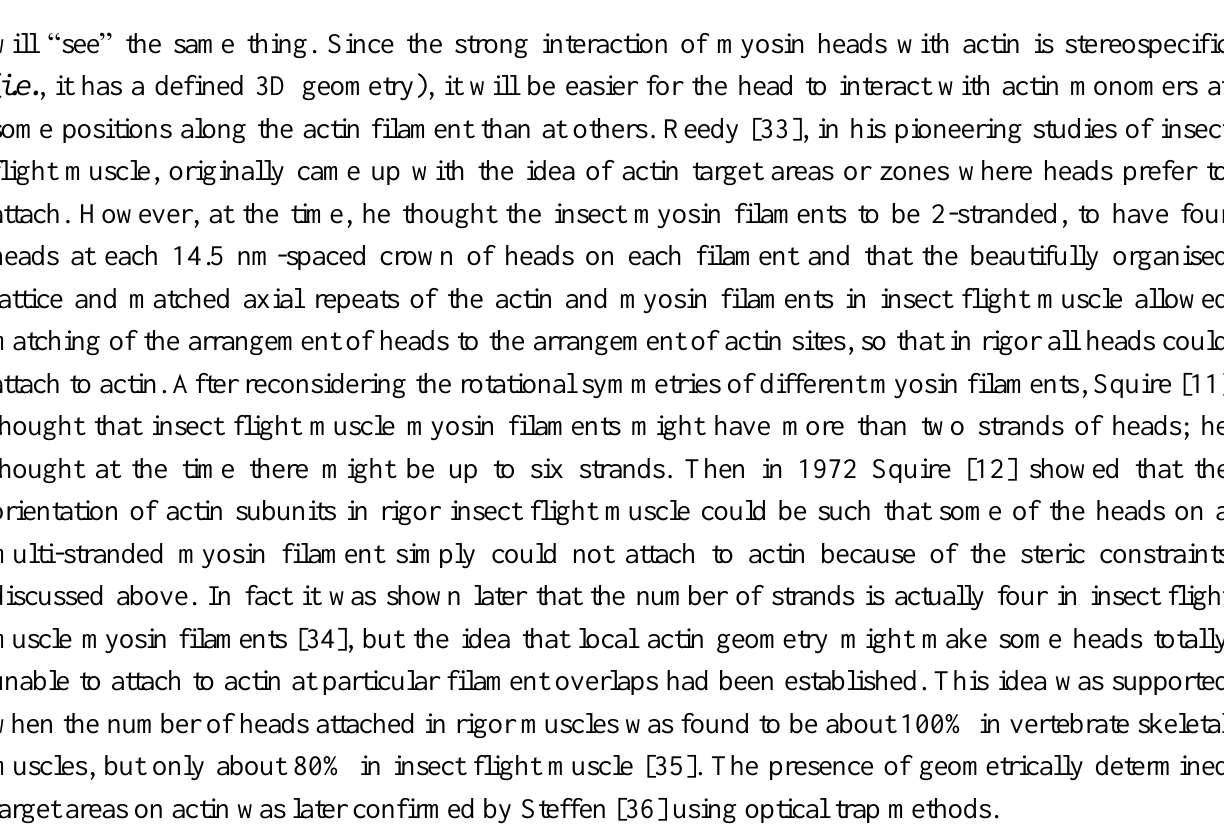
Figure 11. Actin (A) environments in the simple lattice ( a ), and superlattice ( b ), at one crown level along the myosin filaments (M). Each cross-hatched oval shape (C) represents the two myosin heads on each myosin molecule ( cf . Figure 1d). The superlattice in ( b ) has the four heads of two myosin molecules approaching actin filament A1 at this level, and the two heads of one molecule approaching A2. In ( a ), from bony fish muscle, six heads from three myosin molecules approach A1 at this level and no heads approach A2. The